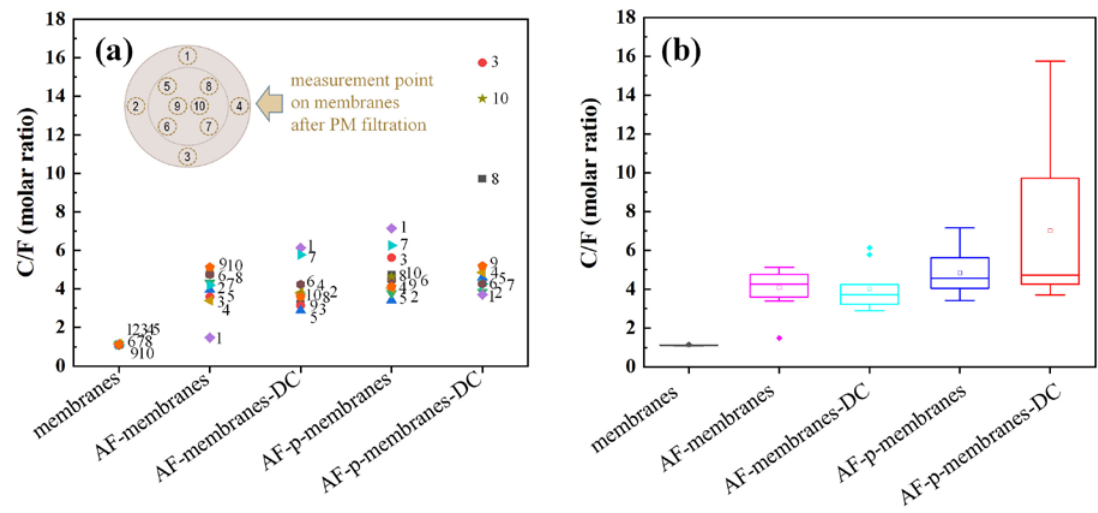
Figure 6. PM capturing efficiency of PVDF/CFO membranes based on Carbon/Fluorine (C/F) molar ratio: ( a ) region-dependent PM capture, and ( b ) the mean value of PM capture. Table 1. C/F molar ratio of the PVDF/CFO membranes. Membranes C/F (Molar Ratio)